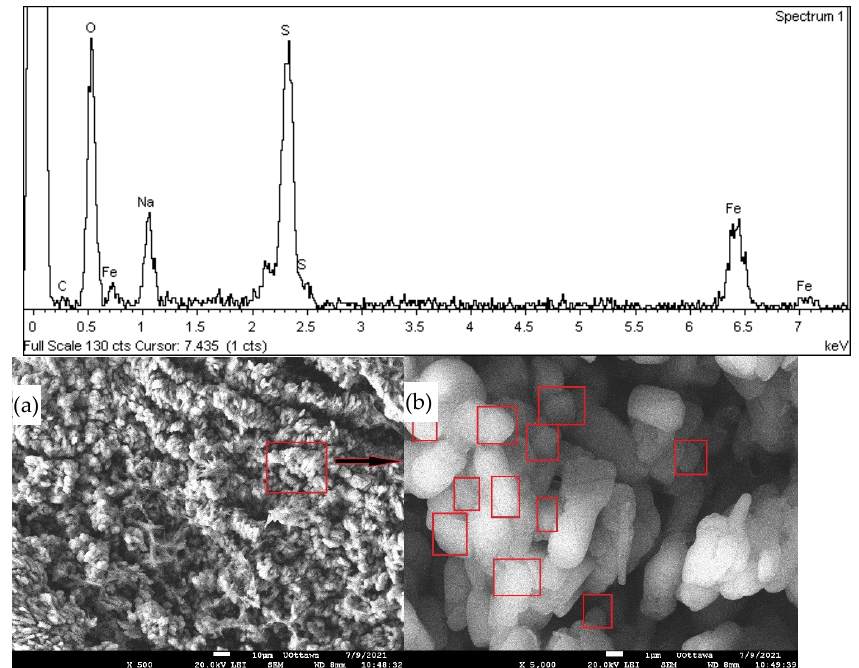
Figure 2. EDX analysis and SEM images and of the mPSS solute particles. The right image ( b ) is a magnification of the red rectangle in the left image ( a ).